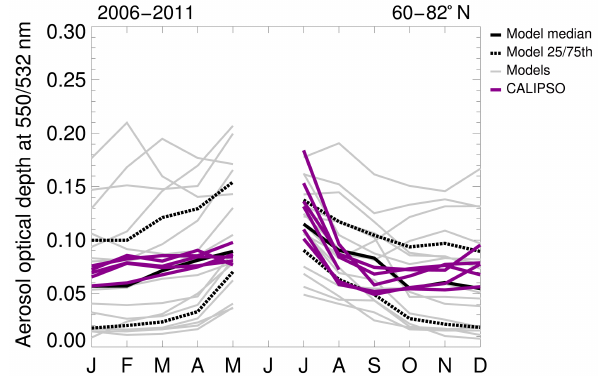
Figure 6. AOD in the Arctic (60–82 ◦ N) from CALIPSO retrieval for the different years 2006–2011 (AOD532nm) (purple lines) com- pared to the AeroCom Phase II models (thin grey lines) screened by CALIOP